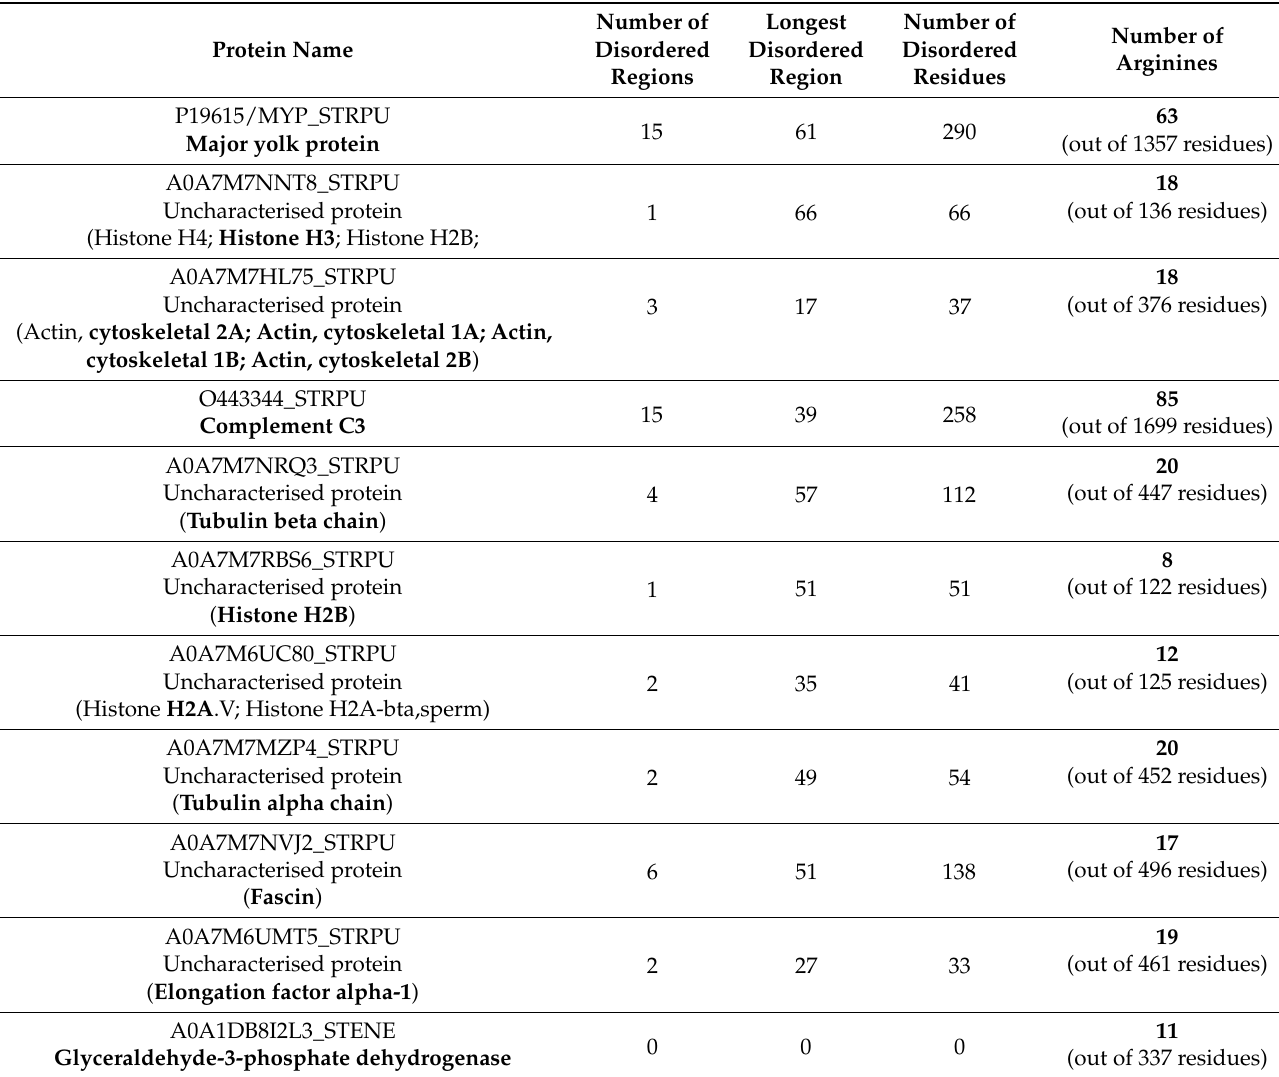
Table 4. FoldIndex© analysis of deiminated purple sea urchin proteins identified by F95 enrichment in coelomic fluid of sea urchin ( Strongylocentrotus purpuratus ). The number of disordered regions, residue length of the longest disordered region, total number of disordered residues, as well as the number of arginines present in the total number of residues for the individual protein hits are shown. Only protein hits with purple sea urchin are shown in this table; the proteins assessed are highlighted in